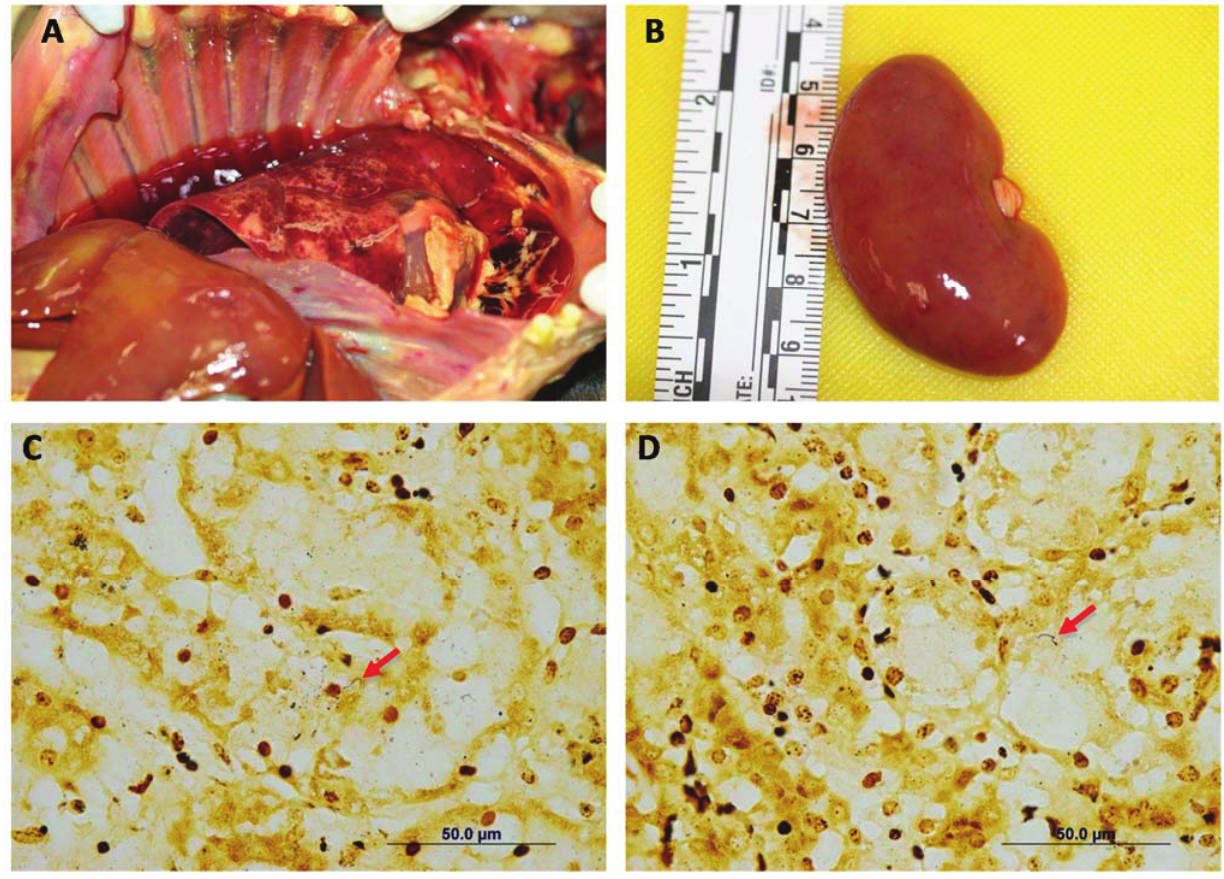
Figure 2. Case 4. Common gross necropsy findings included generalized icterus, petechial to ecchymotic hemorrhages in the lungs ( A ) and kidneys ( B ). In most cases, the liver appeared pale and had an enhanced lobular pattern ( A ). Silver stain showing spiral organisms in the renal interstitium ( C ) and the liver parenchyma ( D ). Warthin Starry Stain